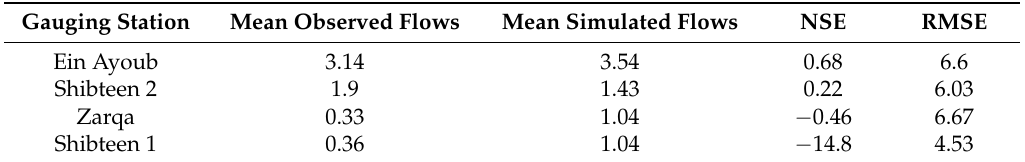
Table 5. Nash–Sutcliff efficiency (NSE) and root-mean-square errors (RMSE) of wadi flows at the four gauging stations.